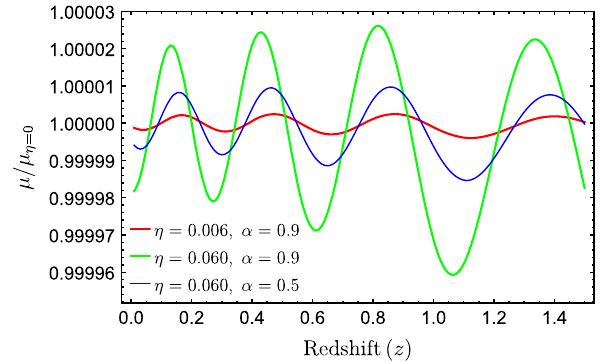
Fig. 15 Variation of distance modulus with redshit z for different cho- sen values of η and α . In this figure, the distance modulus (μ) is parametrized as μ / μ η = 0 , where μ η = 0 is distance modulus where